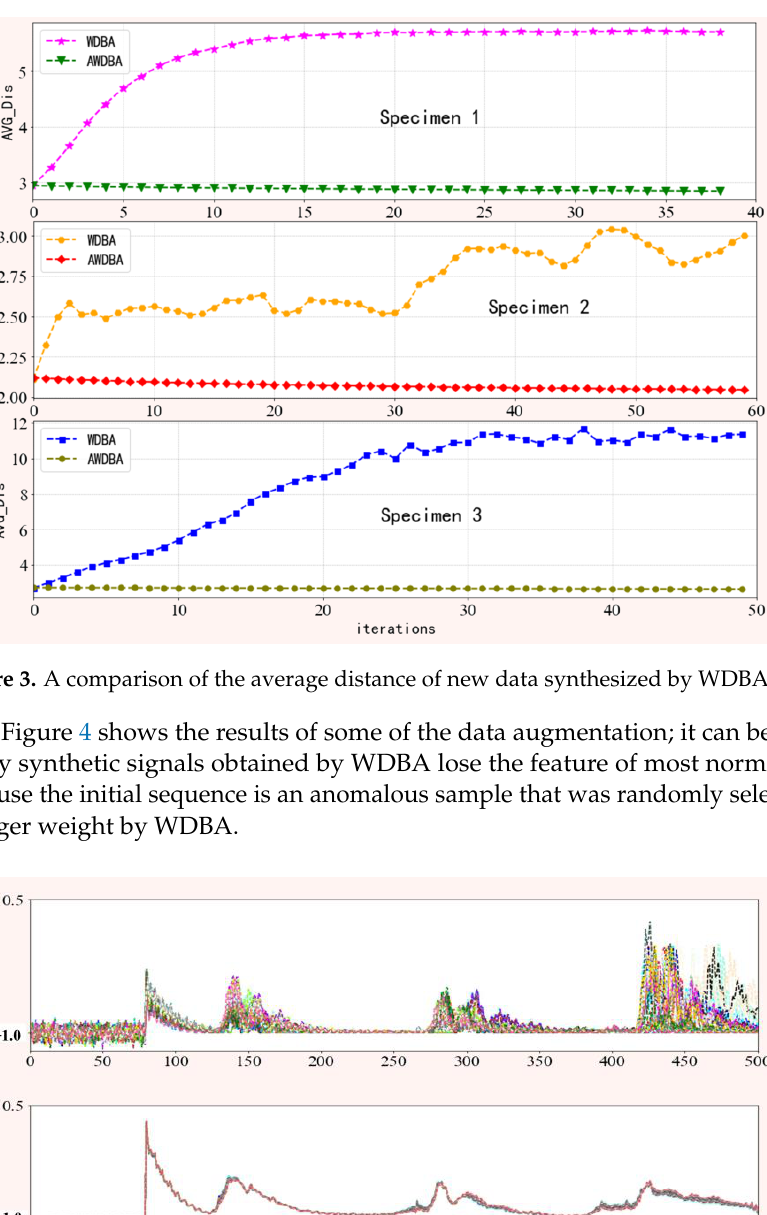
Table 2. Mean value of AVG_Dis for all augmentation data.